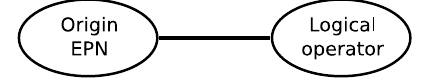
Figure 2.52: The Process Description glyph for logic arc .